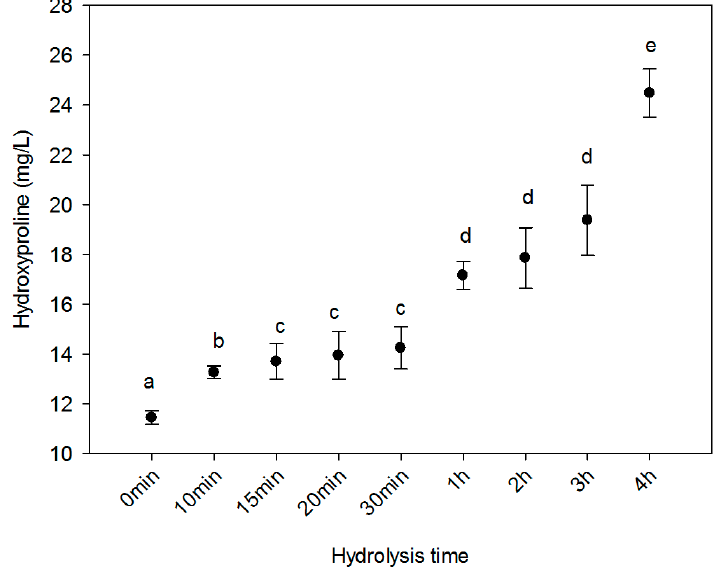
Figure 2. Hydroxyproline concentration in hydrolysed collagen. Different letters indicate significant difference at p ≤ 0.05.